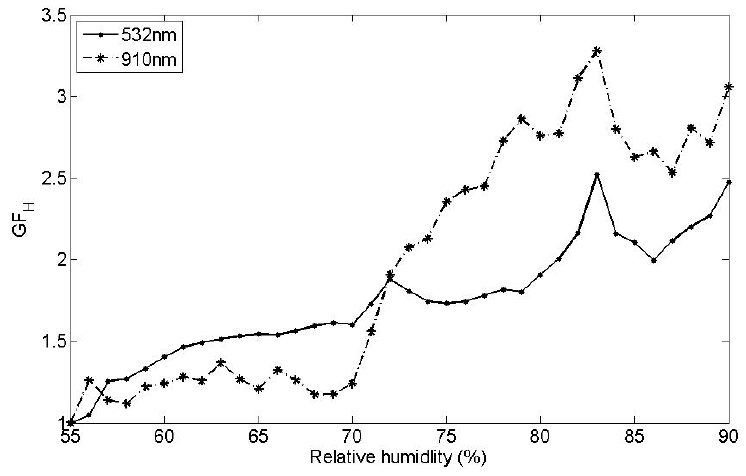
Figure 5. Change of hygroscopic growth factors with relative humidity.